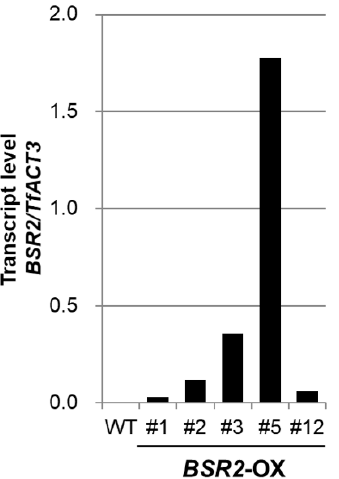
Figure 1. Transcript levels of BSR2 in transgenic torenia lines.